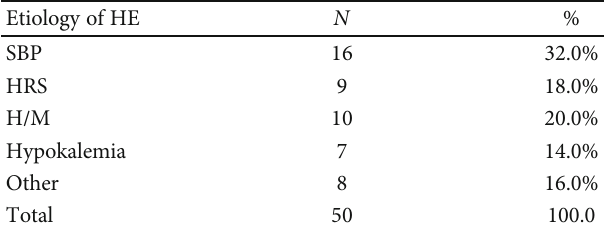
Table 4: Common etiologies of HE in Group 1.